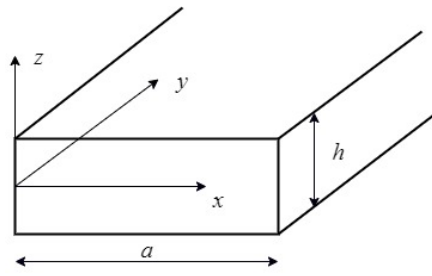
Figure 1. The FG-GPLs reinforced plate in a coordinate system.